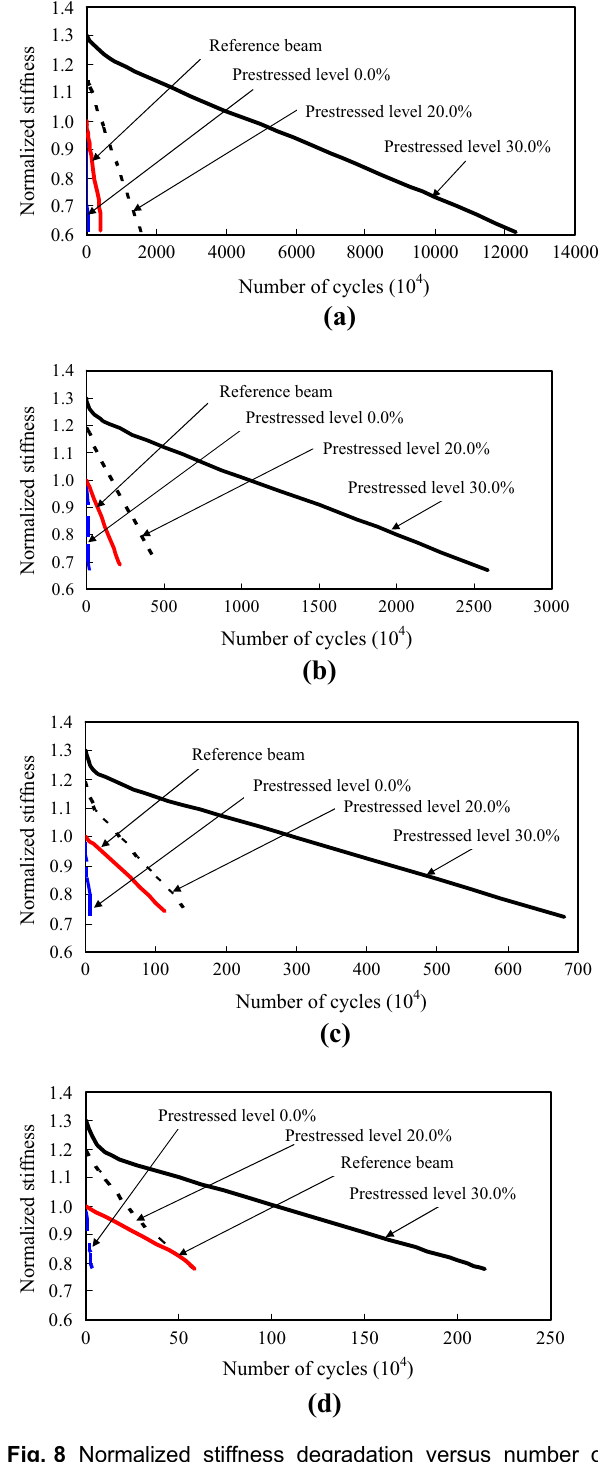
Fig. 8 Normalized stiffness degradation versus number of cycles: a 0.45 load level, b 0.5 load level, c 0.55 load level, and d 0.60 load